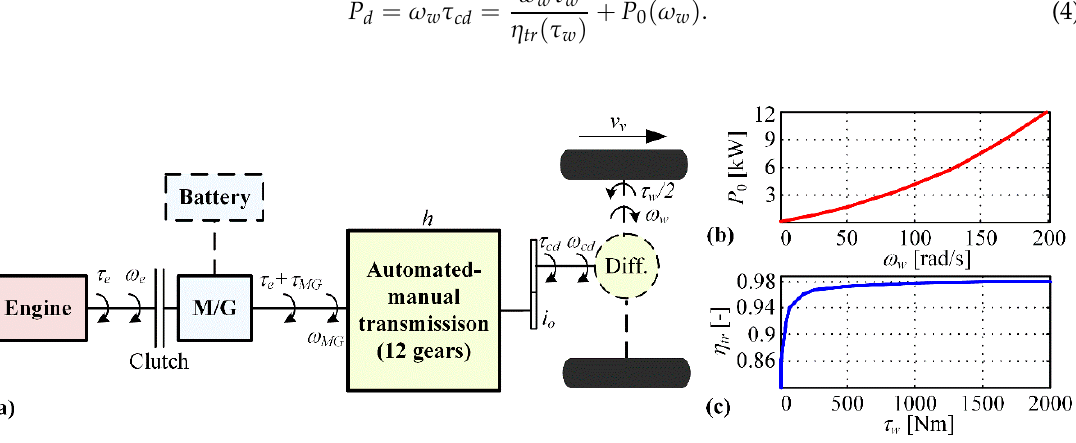
Figure 1. ( a ) Functional scheme of considered parallel PHEV powertrain, ( b ) idling power loss map and ( c ) torque/power transfer efficiency map.